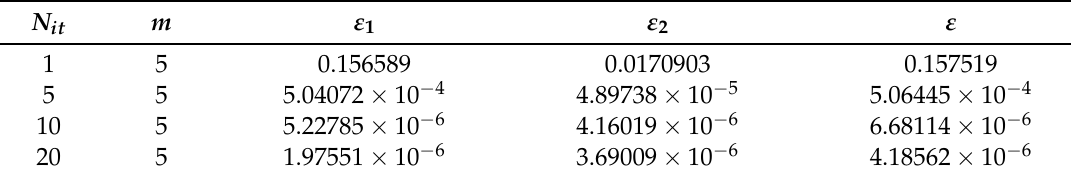
Table 5. Results for problem (32) for m = 5.